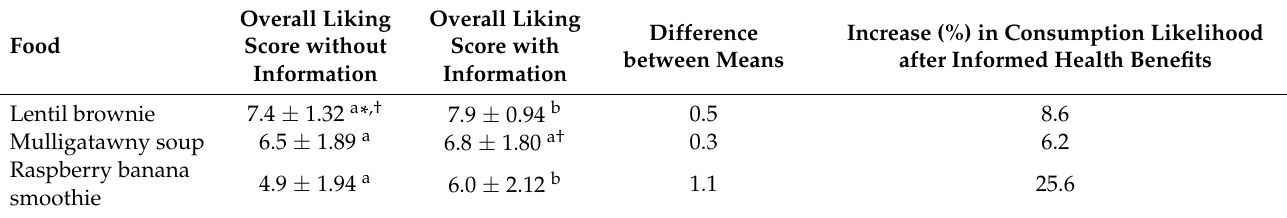
Table 4. Mean hedonic scores for overall liking from sensory evaluation with and without information on the nutrient-dense ingredients and potential health benefits of three foods. A 9-point hedonic scale was used (1 = dislike extremely, 5 = neither like nor dislike, 9 = like